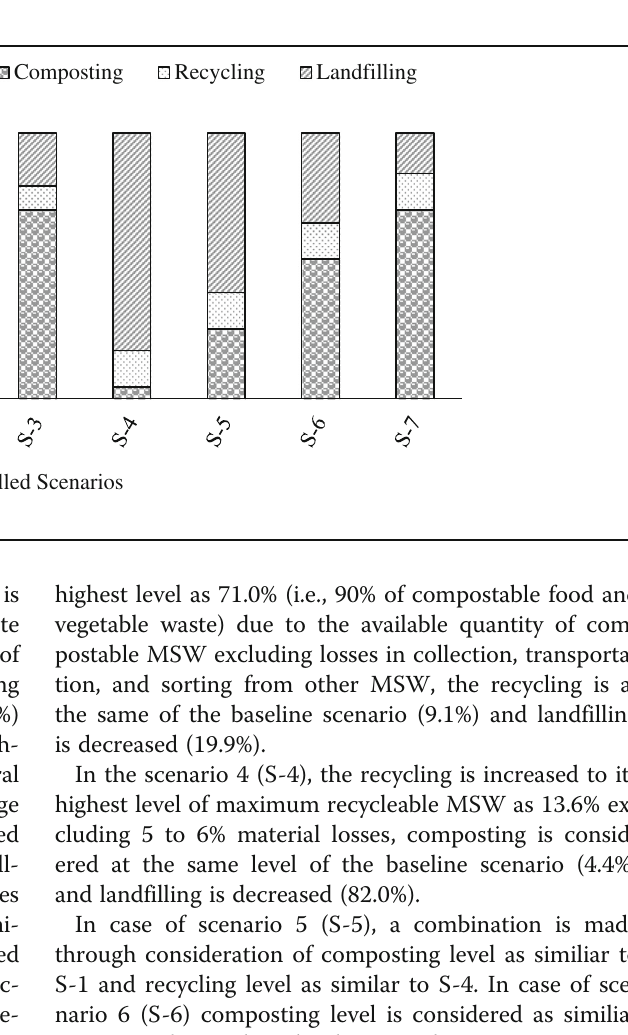
Table 4 Emission of GHGs from modelled scenarios in net LCI Modelled